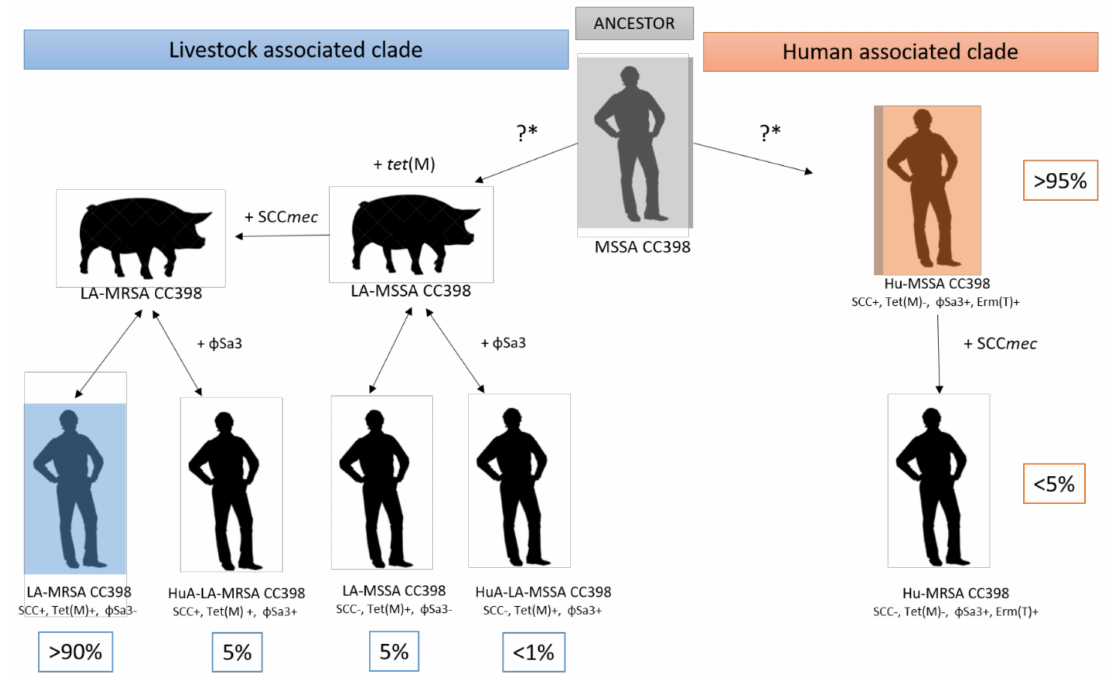
Figure 1. Schematic representation of the evolution of di ff erent subpopulations within the CC398 lineage. The last common ancestor of Staphylococcus aureus (SA) CC398 was probably a human-adapted immune evasion cluster (IEC)-positive methicillin-susceptible SA (MSSA) CC398 strain, which at a later stage acquired SCC mec , leading to the emergence of human methicillin-resistant SA